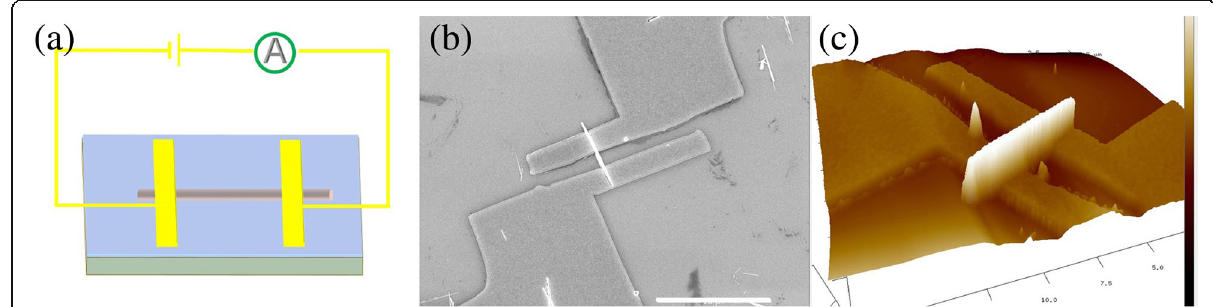
Fig. 3 a The schematic illustration of individual NiCo2O4 nanowire device. b , c The SEM image and 3D AFM topographic image of the Au/Cr electrode